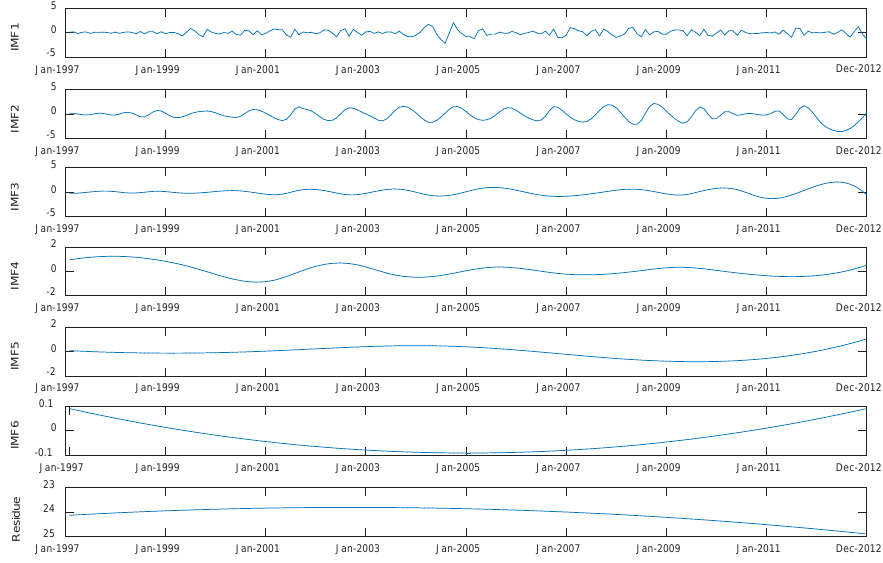
Figure 10. Decomposition of groundwater level time-series at the STL185 observation well.